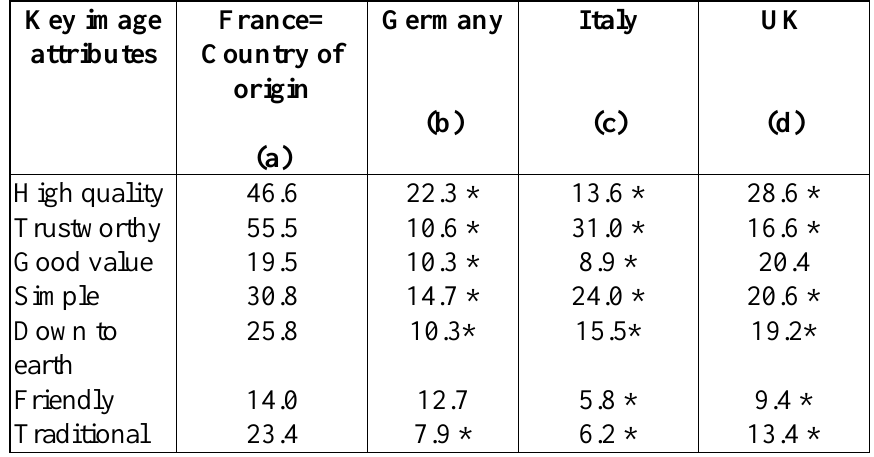
Table 3: Evian Key Image Attributes in Country of Origin Versus other Countries Key